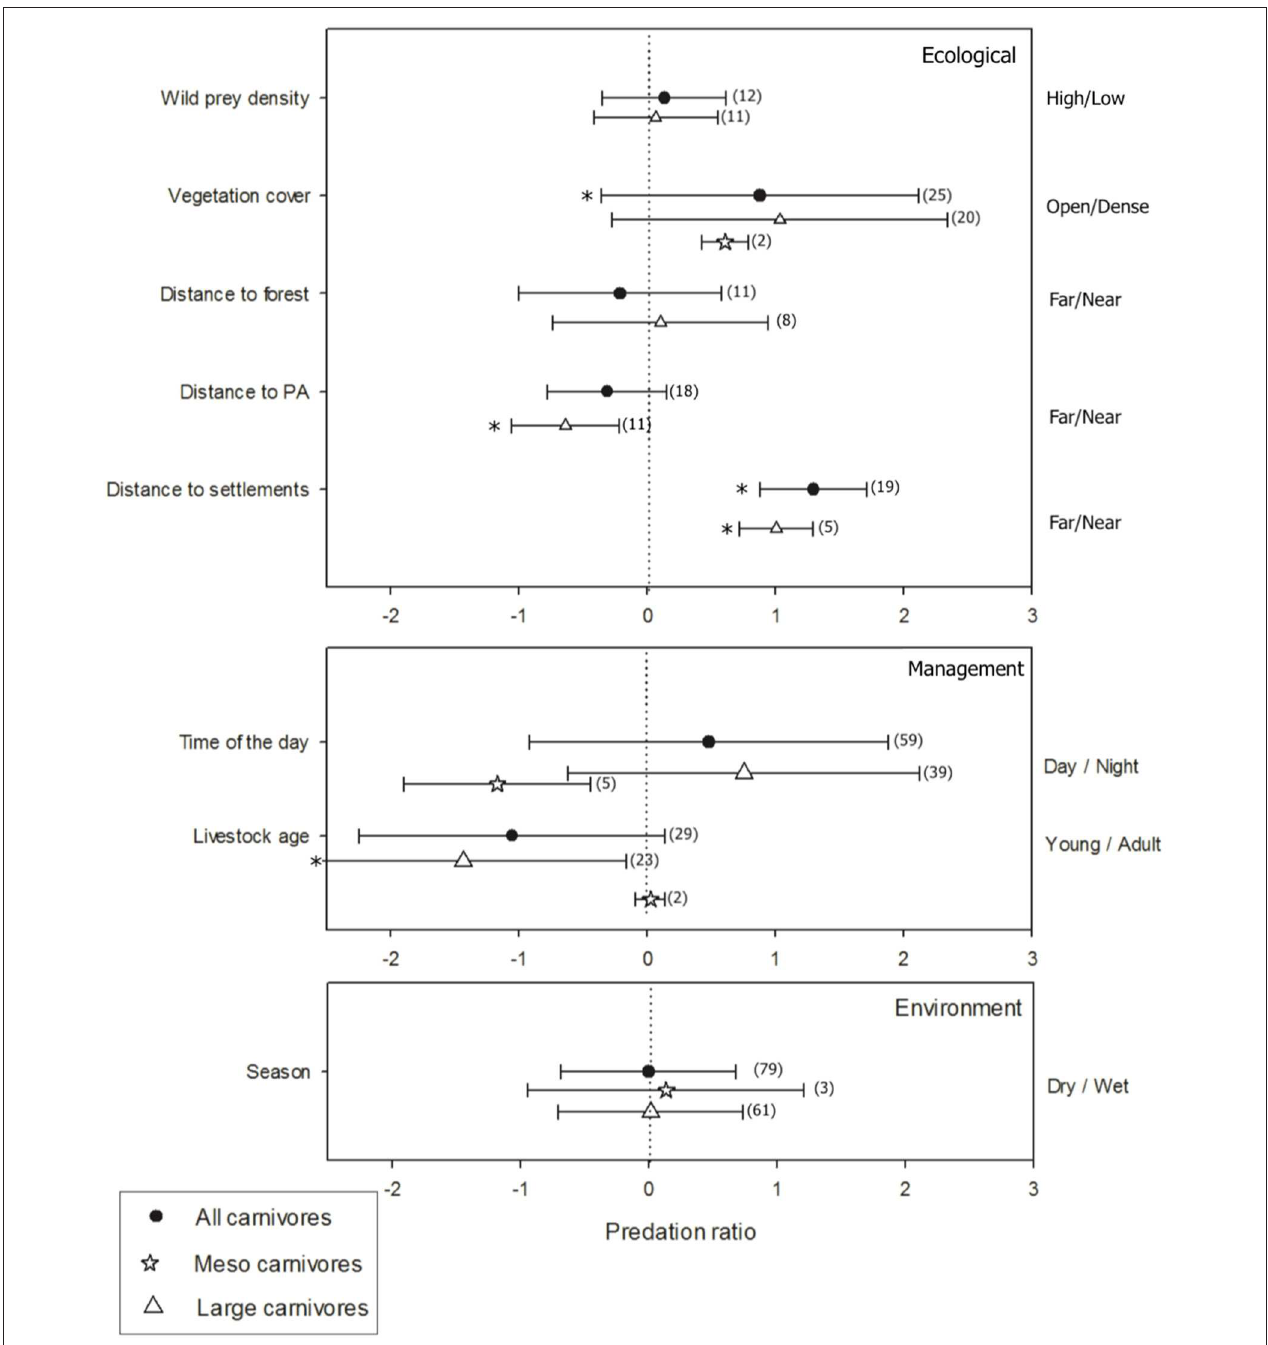
FIGURE 4 | Predation ratio (ln) as a response to ecological conditions: wild prey abundance (high/low), vegetation cover (dense/open), and distance to forest patch, protected area and human settlement (far/near); environmental conditions: season (dry/wet); and management practices: livestock age (young/adults) and moment of the day (day/ night). The number of study cases considered for each ecological/environmental condition and management practice is shown in parentheses. *Denotes significant effect at p < 0.05.